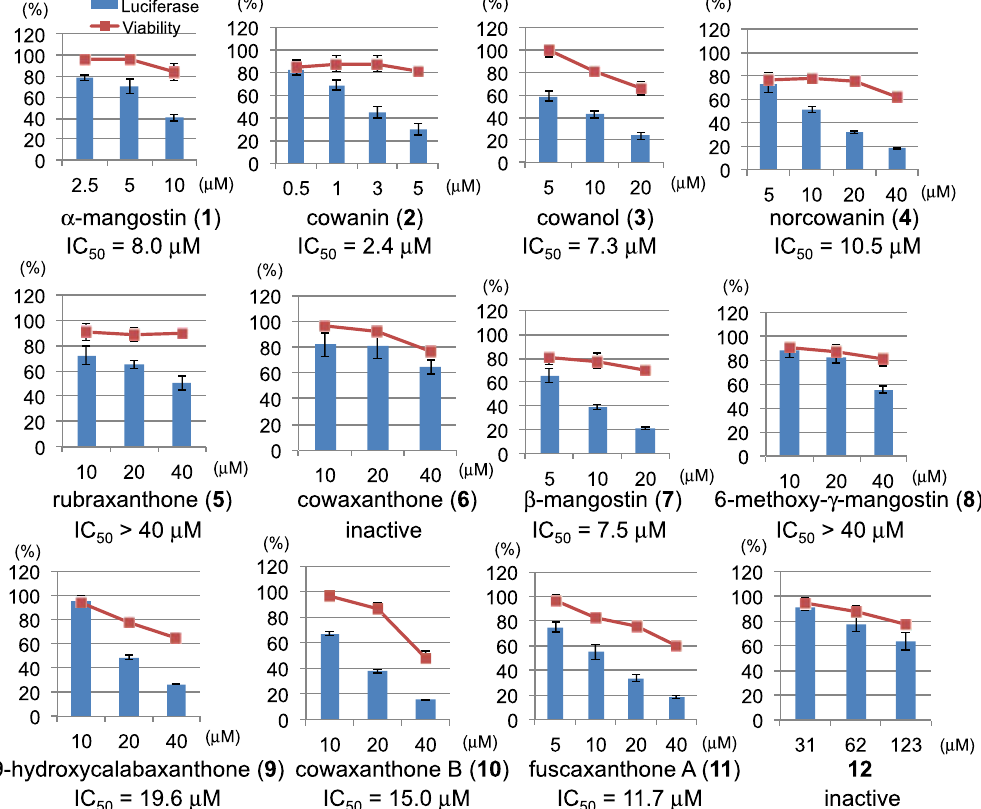
Figure 5. Inhibition of Notch transcriptional activity and cell viability by 1 – 12 . Assay cells (LS174T Notch cells: 2 × 10 4 cells/well) were incubated in a 96-well white plate at 37 °C for 12 h. After incubation, 50 ng/mL Dox was added to each well to induce expression of exogenous Notch1(1704–2531) protein. After incubation at 37 °C for 12 h, the medium was changed to Dox-free medium containing individual samples. Luciferase activity was measured after treatment at 37 °C for 12 h. Cell viability was evaluated by the FMCA method at the same time. These assays were performed in 0.1% DMSO (n = 3). Error bars represent